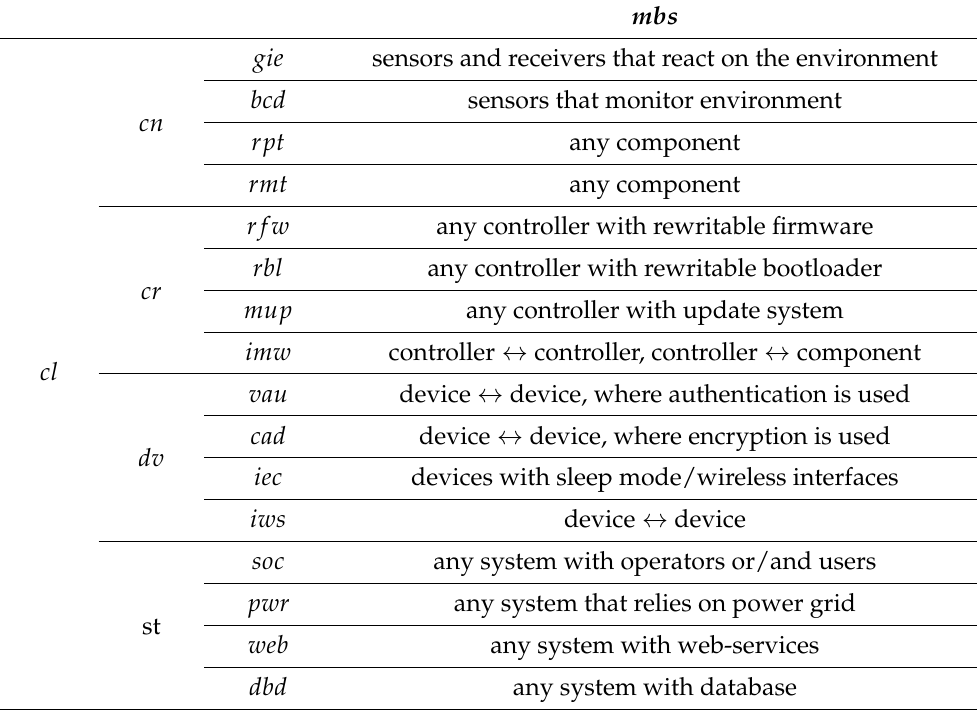
Table 7. Classes of attack actions and non-security